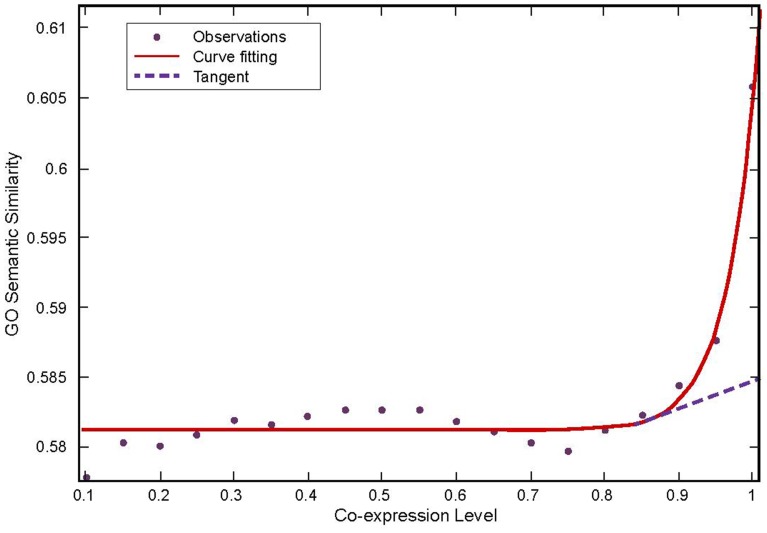
Co-expression Level and GO Semantic Similarity.Purple point means observations, red line indicates the curve fitting, the dotted curve represents the first order tangent.